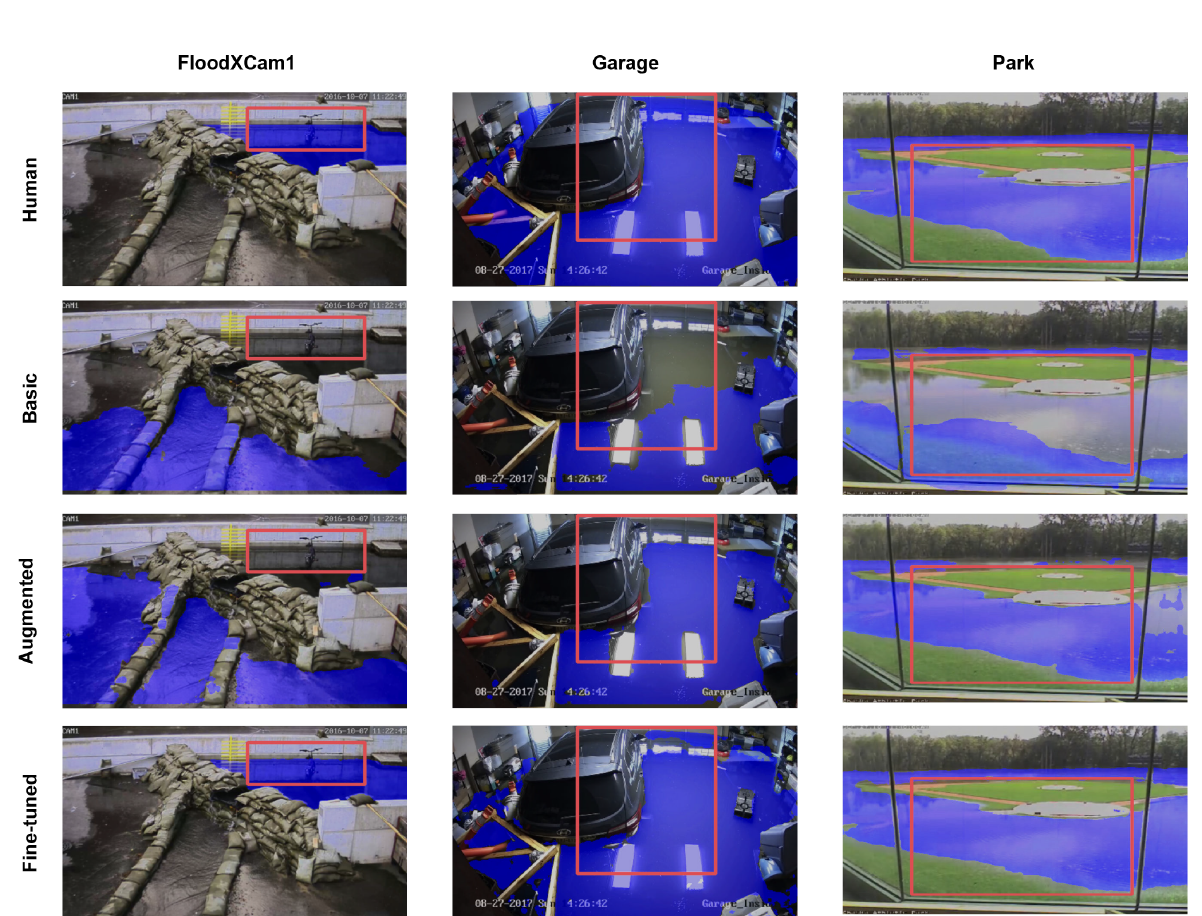
Figure 4. Sample frames taken from three of the six analyzed surveillance videos, shown with the human label or automatic flood segmen- tation in blue and the regions of interest (ROI) in red. The samples show how the Augmented strategy improves segmentation in the Garage and Park samples, but the segmentation for FloodXCam1 is only successful with the Fine-tuned training strategy. The sample frames from the remaining three videos are provided in the